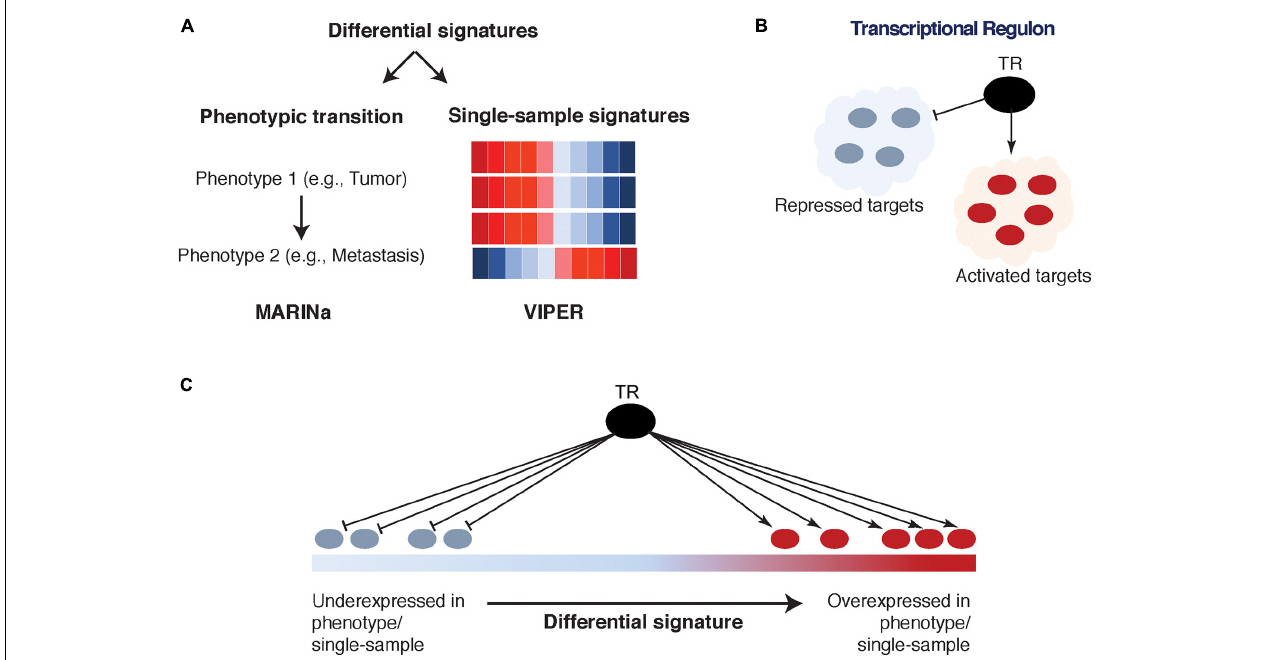
FIGURE 3 | Interrogation of transcriptional regulatory networks: Master Regulator Inference Algorithm (MARINa) and Virtual Inference of Protein-activity by Enriched Regulon analysis (VIPER). (A) A differential signature is defined between two phenotypes of interest (left) as input to MARINa; or on a single-sample level (right) as input to VIPER. (B) The transcriptional regulon is identified from Algorithm for the Reconstruction of Gene Regulatory Networks (ARACNe) tissue-specific transcriptional regulatory network, which includes a transcriptional regulator (TR) and its activated and repressed targets. (C) The activated and repressed targets of the regulon are mapped onto the corresponding signature and used to determine the TR’s transcriptional activity.